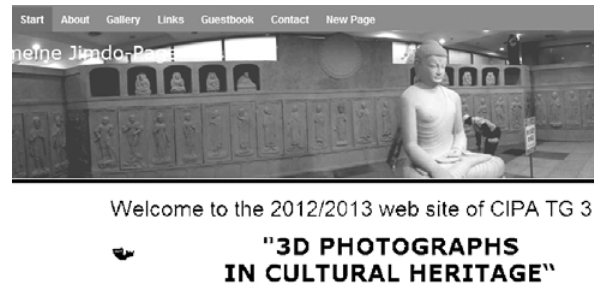
Figure 13. Panorama photography of the 1 st page of the web site www.3dphoto.jimdo.com of CIPA task group 3 on “3D photographs in Cultural Heritage” (photography by W.